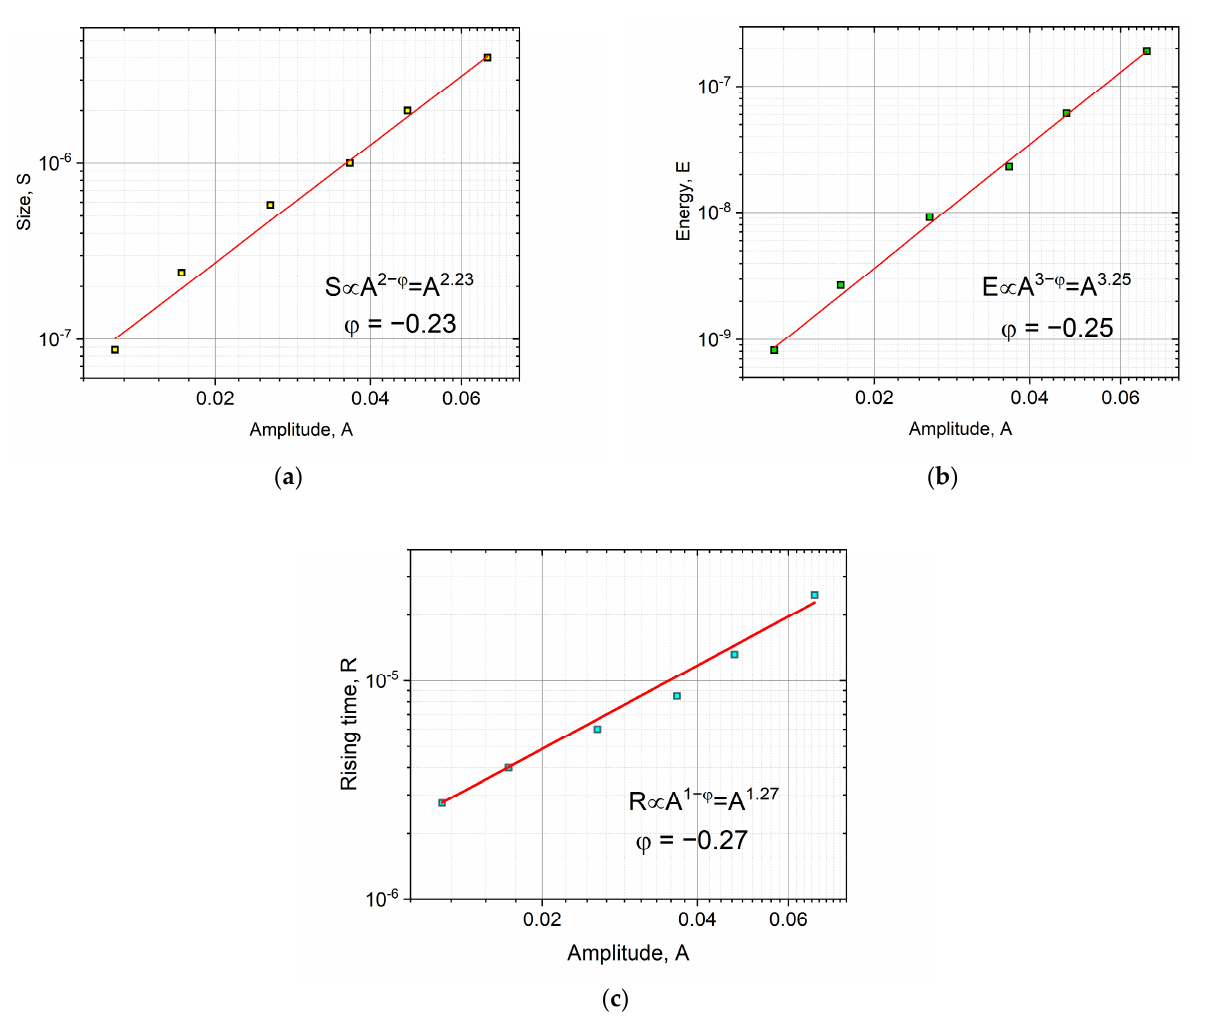
Figure 10. Scaling functions between the ( a ): averaged avalanche area, S , and amplitude, A , ( b ): aver- aged energy, E , and amplitude; as well as ( c ): averaged rising time, R , and amplitude. The ϕ values from the fittings of ( a – c ) are − 0.23 ± 0.03, − 0.25 ± 0.02, and − 0.27 ± 0.02,